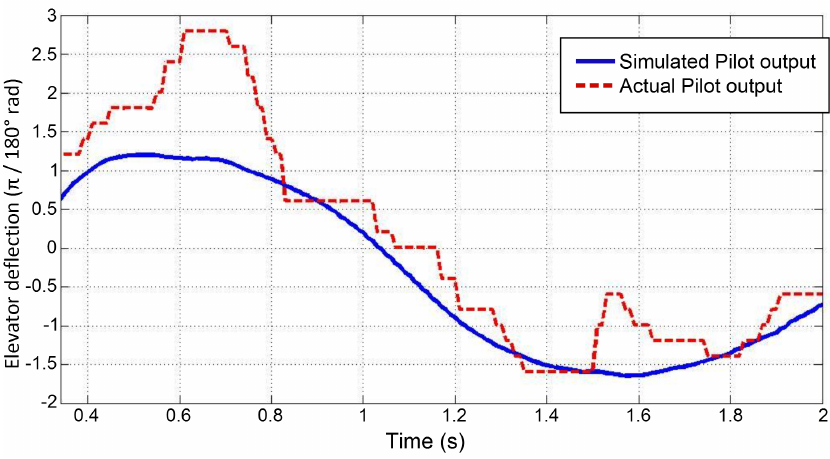
Figure 13. Estimation example for SLFP portion for lead-lag pilot